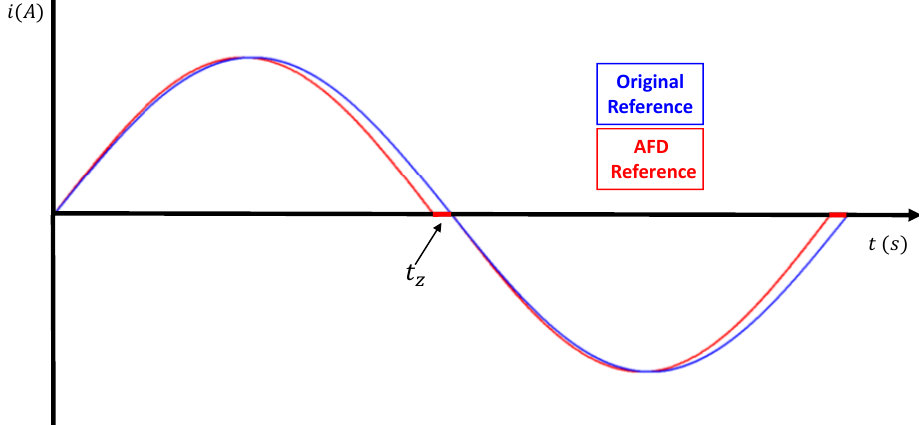
Figure 1. AFD current waveform compared to an ideal sinusoidal reference. factor ( c f ), defined as the ratio between the double of the dead time and the current nominal